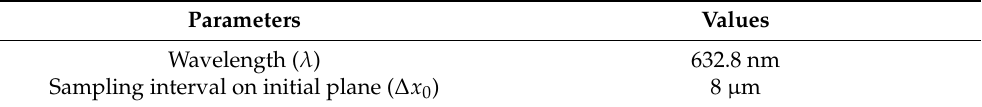
Table 1. The Simulation Parameters of Verification 1 of the Sampling